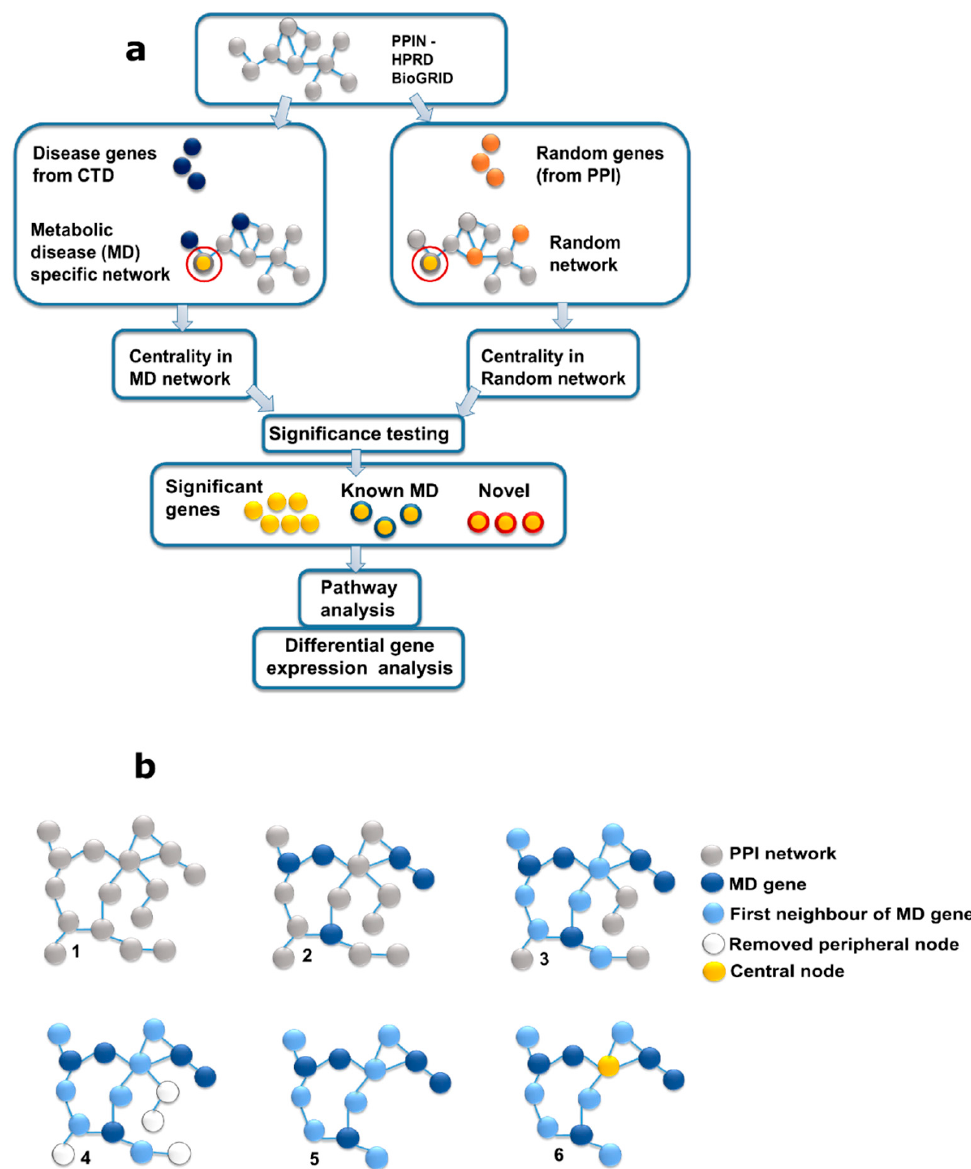
Figure 1. Graphical outline of the method; ( a ) outline of the proposed method; Comparative Toxi- cogenomics Database (CTD) and two protein–protein interaction (PPI) networks (Human Protein Reference Database (HPRD) and BioGRID) were used to build an metabolic diseases (MD)-specific network. To correct for degree bias, random networks were constructed using similar degree dis- tribution as in the original MD network. On obtaining the centrality scores in the MD network and random networks, significance testing was carried out to assign p -values to the nodes. Nodes that showed significantly different centralities between the MD and random networks were subjected to a Pathway analysis. The novel genes identified were subjected to differential gene expression analysis. ( b ) MD specific network construction: 1. PPI giant component, 2. map-known MD genes onto PPI, 3.sselect first neighbors, 4. select interactions between first neighbors (if exist), 5. Remove single degree peripheral nodes (except MD), 6. centrality analysis of the network. Random networks for comparison were built using the same procedure, except, instead of the MD nodes from CTD, nodes were selected randomly from the PPI networks. The degree distribution of MD nodes in the MD-specific network was mimicked in the random networks.